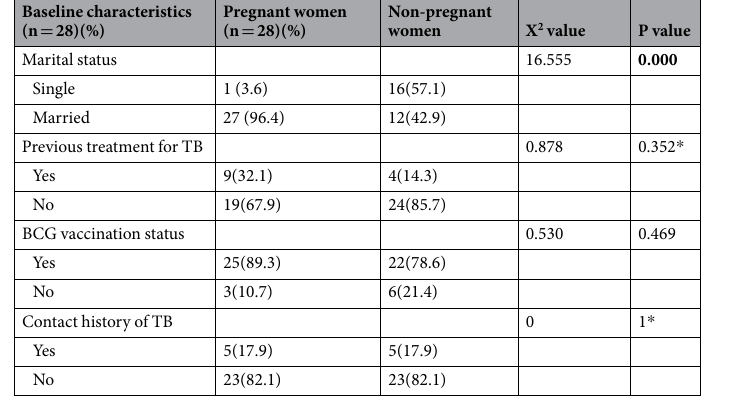
Table 1. Baseline characteristics of pregnant women and non-pregnant women. Categorical data was compared using the Chi-square test or Fisher’s exact test. Statistical significance set to P < 0.05 and was emphasized in bold. * Fisher’s exact